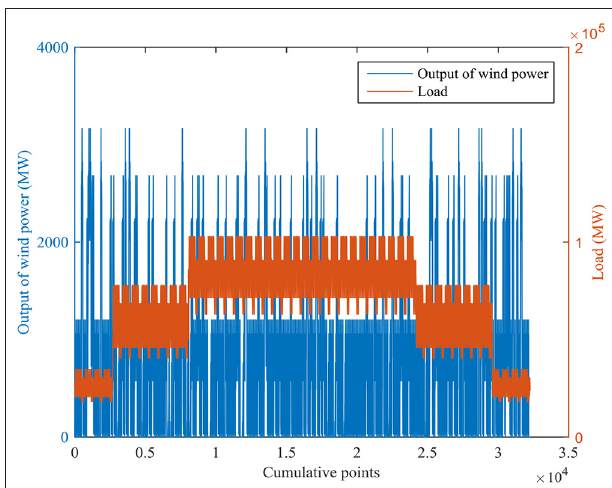
FIGURE 7 | Relationship between Wind Power output and load.